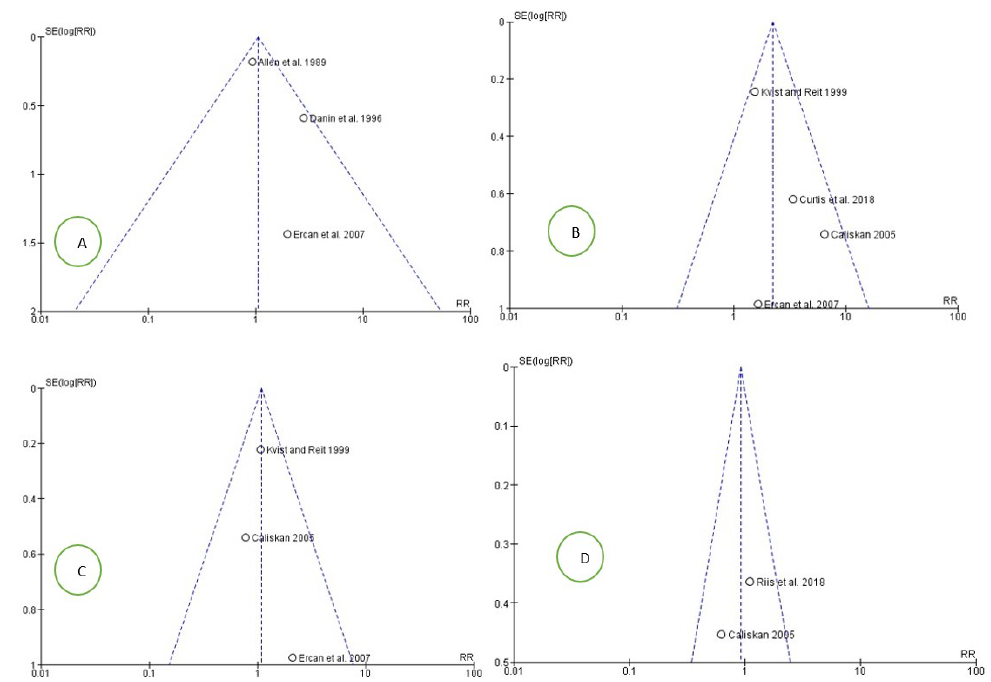
Figure 6. Funnel plot: ( A ) follow-up 1 year; ( B ) follow-up 2 years; ( C ) follow-up 3–4 years; ( D ) Follow-up 8–10 years. RR risk rate; SE standard error. Graphically, there are no sources of heterogeneity.